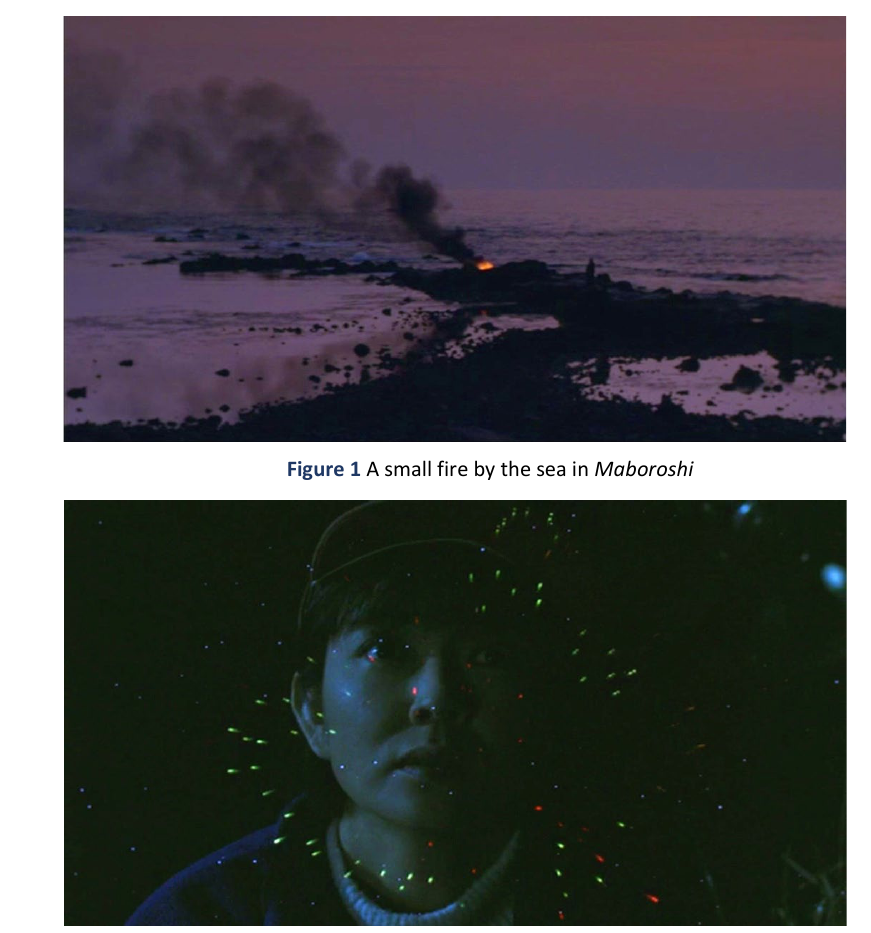
Figure 2 Detective’s wife and the fireworks in HANA-BI.